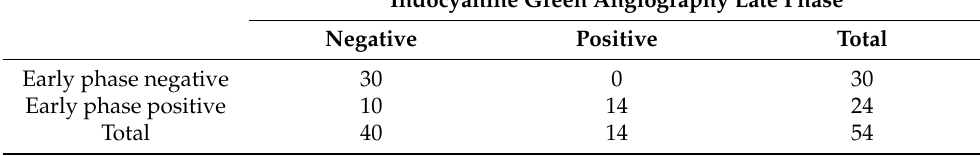
Table 3. Comparison of the early and late phases of indocyanine green angiography images for the detection of neovascular networks.